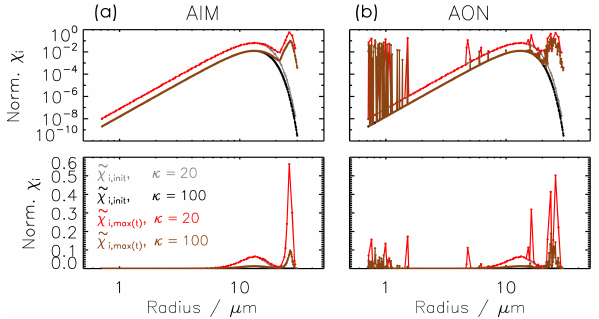
Figure 20. Normalised SIP mass e χ i as a function of the initial χ i / M (ν i µ i )/ M ; i.e. the to- SIP radius r i . e χ i is defined as = = tal droplet mass in a SIP is normalised by the total mass within the grid box. e χ init denotes e χ i of the initial SIP ensemble. e χ max denotes the maximum e χ i value each SIP attains over the course of a simu- lation. The left and right panels show AIM/AON simulations with κ 20 or 100 (see legend). Both algorithms use the singleSIP-init = and (cid:49)t 10s. The plots show results from a single =